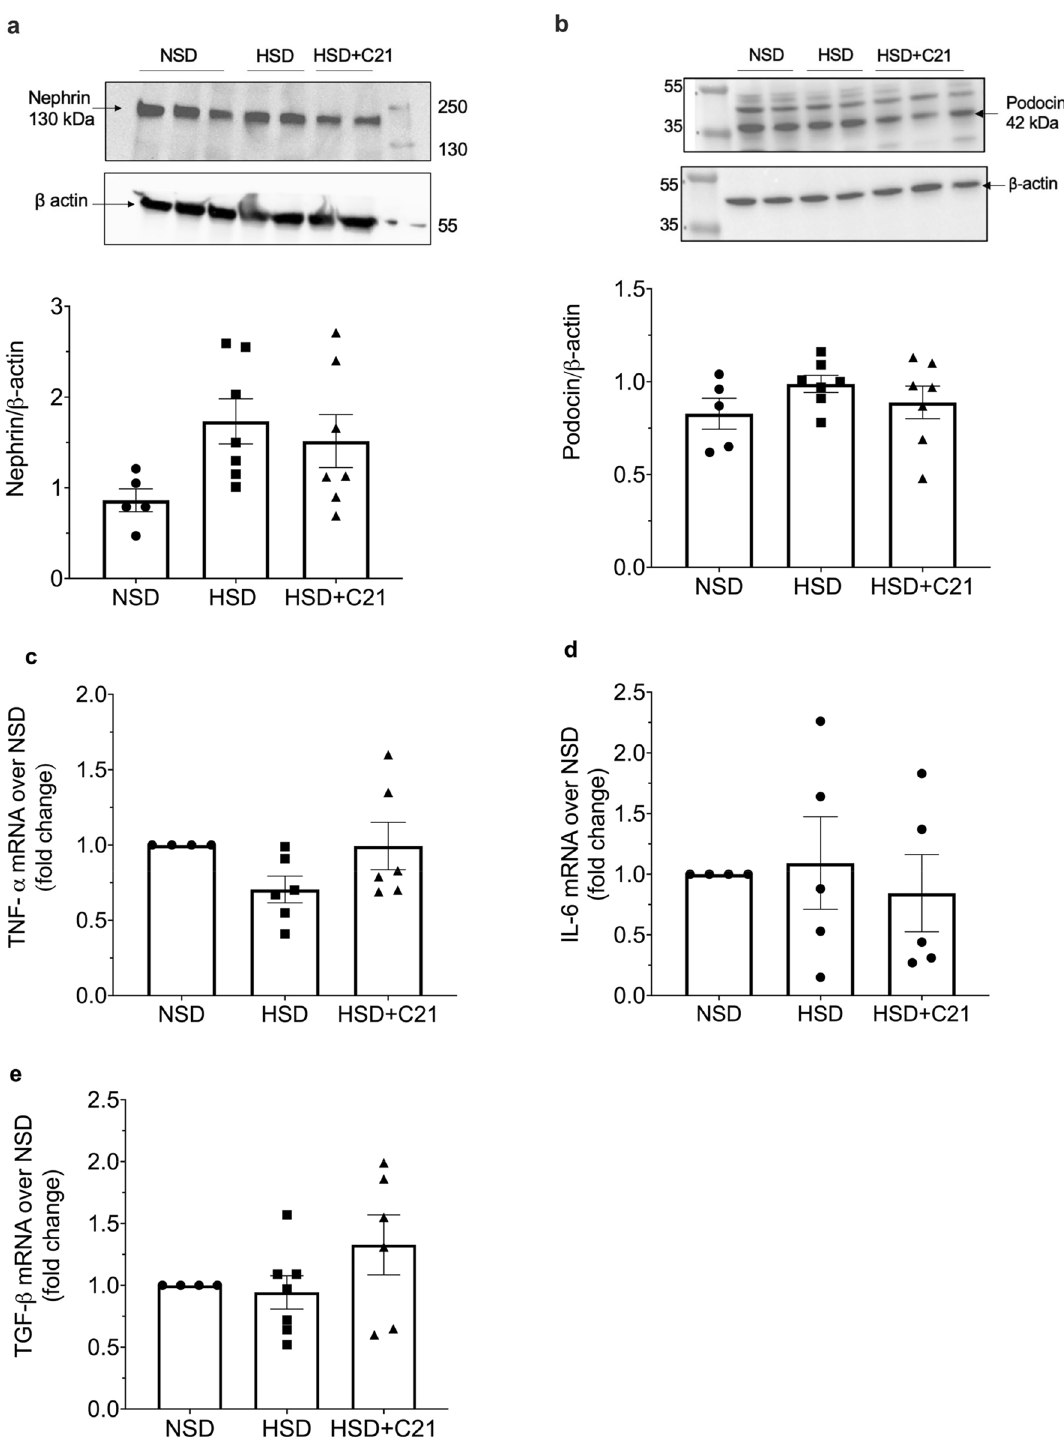
Figure 5. Representative western blots of expression of glomerular injury markers nephrin ( a ) and podocin ( b ) and the blots are used from the respective gels. Densitometry of the bands was normalized with β-actin expression. Quantitative mRNA analysis of TNF-α, IL-6 and TGF-β ( c – e ). Values are represented as mean ± sem; one-way ANOVA followed by Fisher’s LSD